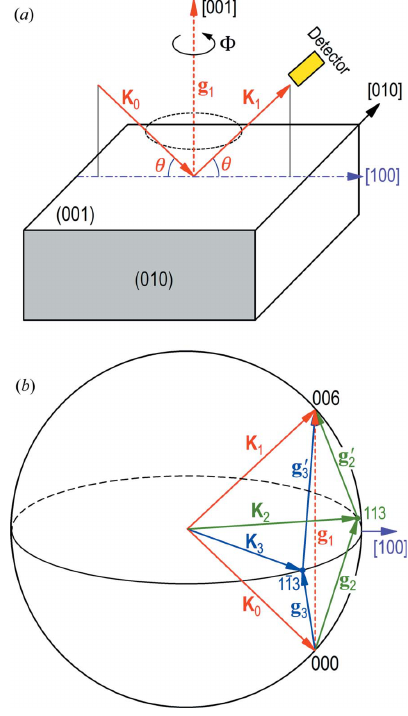
Figure 1 000 = 006 = 113 = 1 (cid:3) 113 4BD configuration. ( a ) Diffraction geometry of the 006 main reflection in real space with the plane of incidence parallel to (010). K 0 is the incidence wavevector, and K 1 is the 006 reflection wavevector. The dashed circle indicates the diffraction cone of g 1 formed by rotation of K 0 and K 1 around g 1 . ( b ) The Ewald sphere in reciprocal space. The four reciprocal lattice points 000, 006, 113 and 1 (cid:3) 113 are all on the Ewald þ g 0 þ g 0 sphere. g 1 = g = g 2 3 2 3